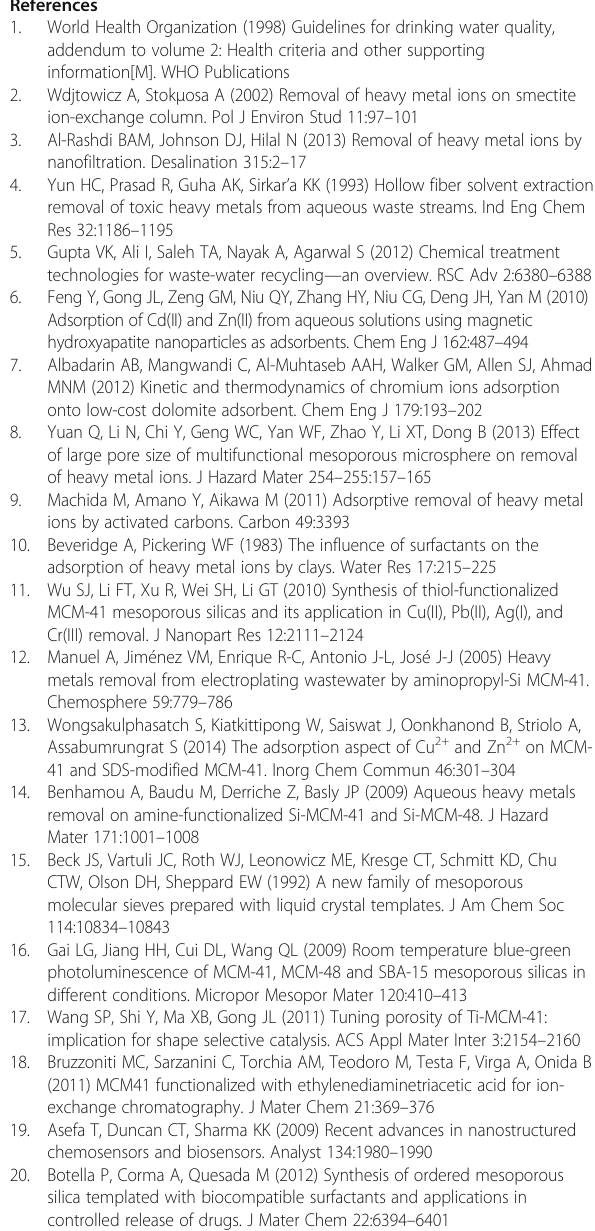
Fig. 7 Plot of interparticle diffusion model for adsorption of Cu 2+ , Pb 2+ , and Cd 2+ onto the